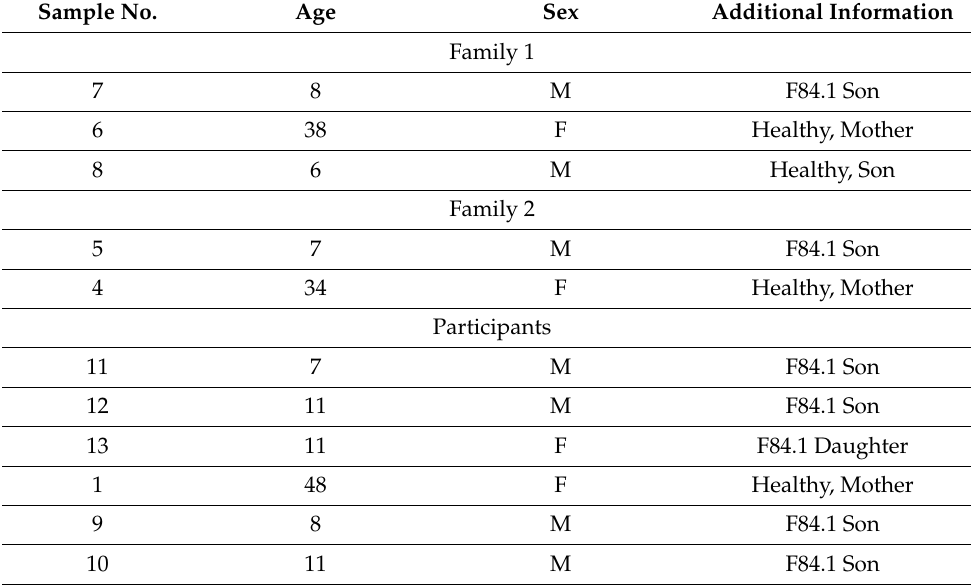
Table 2. Demographic data of study participants. Sample